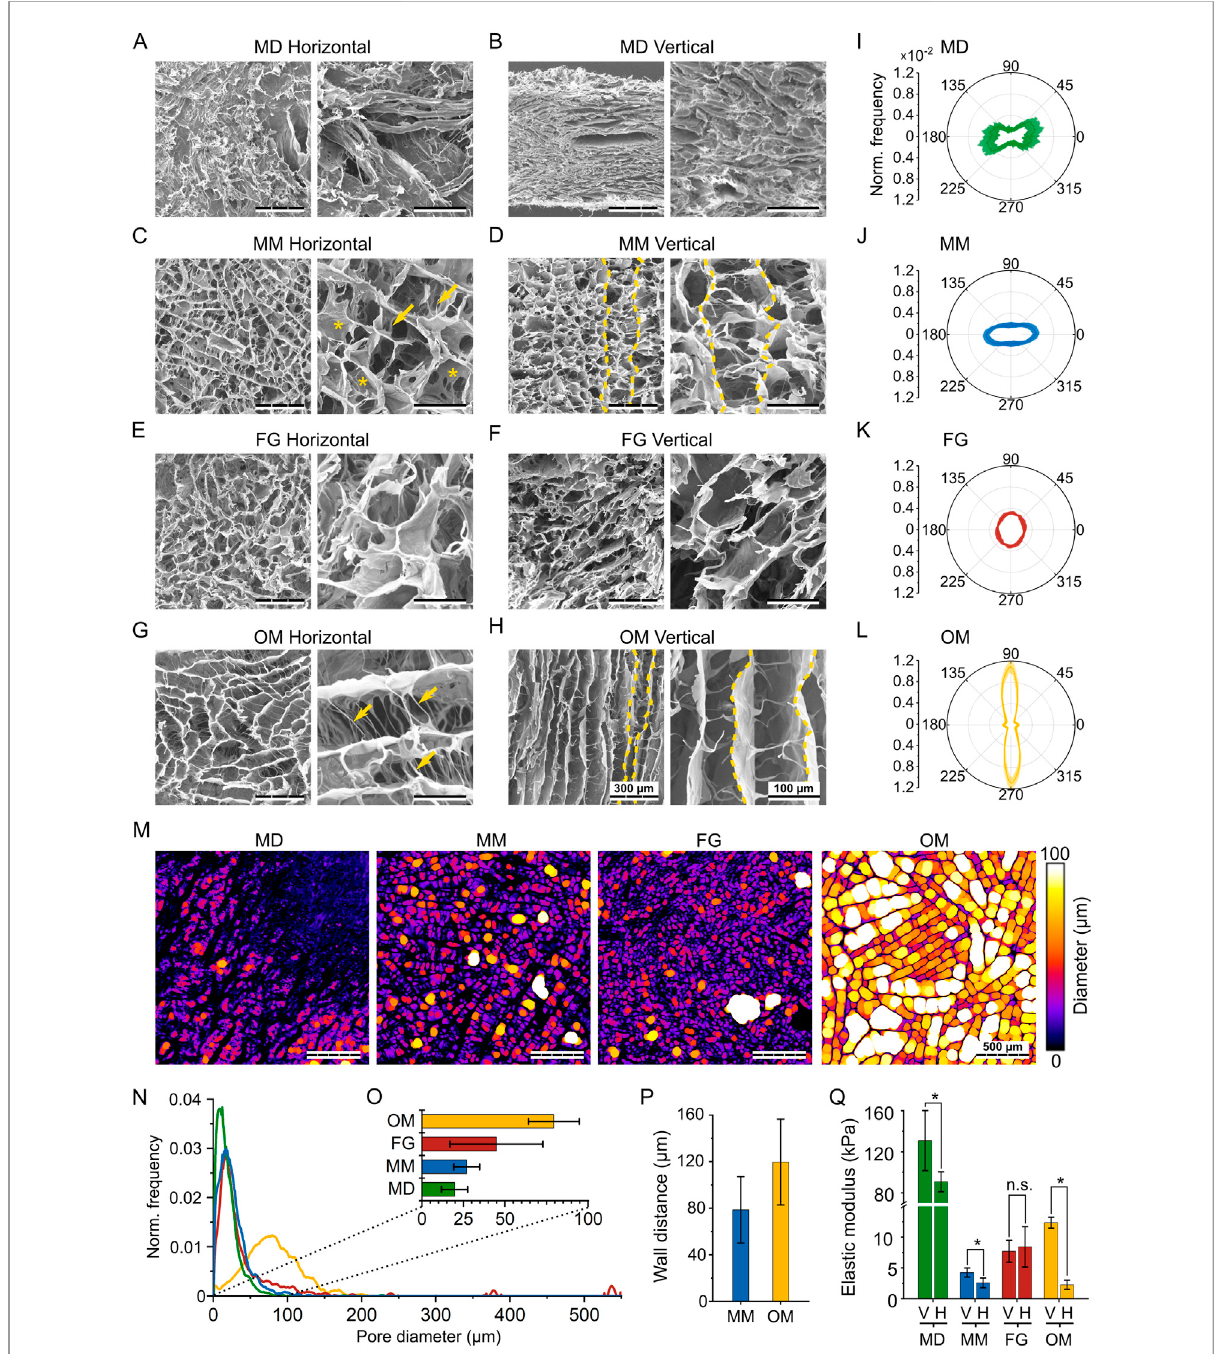
FIGURE 3 Structural and mechanical characterization of the investigated biomaterials. (A,C,E,G) SEM images of the horizontal plane of MD, MM, FG, and OM, respectively; (B,D,F,H) SEM images of the vertical plane of MD, MM, FG, and OM, respectively. For each material, images on the right show the internal structure at a greater magni fi cation. Scale bars are 300 µm (overview) and 100 µm (magni fi cation). In (D and H) , yellow dashed lines mark representative vertical walls. In the higher magni fi cation images of (C and G) , arrows and asterisks highlight fi ber- and sail-like horizontal bridges, respectively; (I – L) normalized distribution of orientation in MD, MM, FG, and OM. Orientations of 0 ° and 90 ° indicate the horizontal and vertical directions, respectively. Results are shown as mean values (solid line) ± standard deviation (shaded area); (M) Representative images visualizing the automated pore size measurement in the investigated biomaterials. Colors indicate the diameters of the spheres that were fi tted into the pores, while black areas represent the material. Scale bar is 500 μ m; (N) Frequency distribution of the automatically measured pore diameters. Results were normalized to the sum of all measured diameters and the curve was smoothened for better representation; (O) mean pore size ±standard deviation derived from the automated measurements; (P) average wall distance ±standard deviation in MM and OM obtained